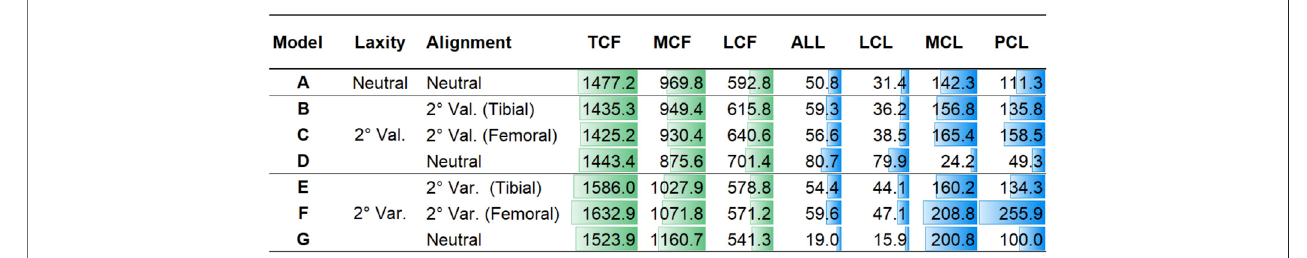
FIGURE 6 | Peak TCF, MCF, and LCF and peak tension force of the ALL, LCL, MCL, and PCL in models A – G in Newton.